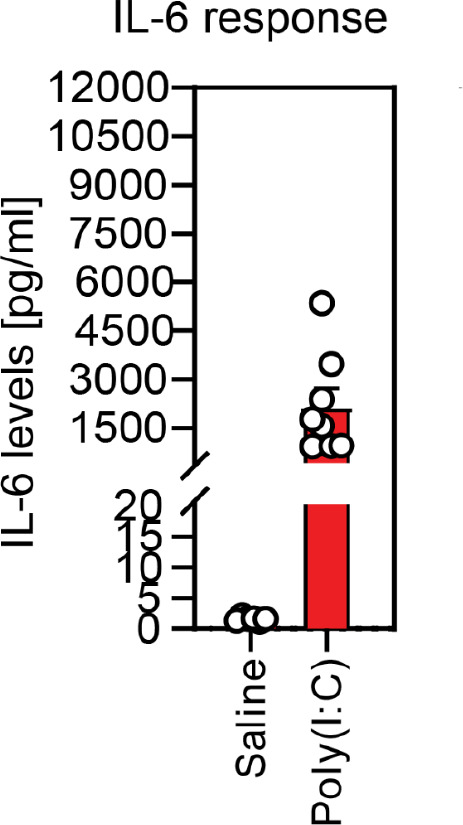
Validation of responsiveness to poly(I:C) based on dam serum IL-6 levels.Injection of poly(I:C) at E12.5 consistently elevates serum IL-6 in dams 4 hr following injection, compared with little response in dams injected with saline.